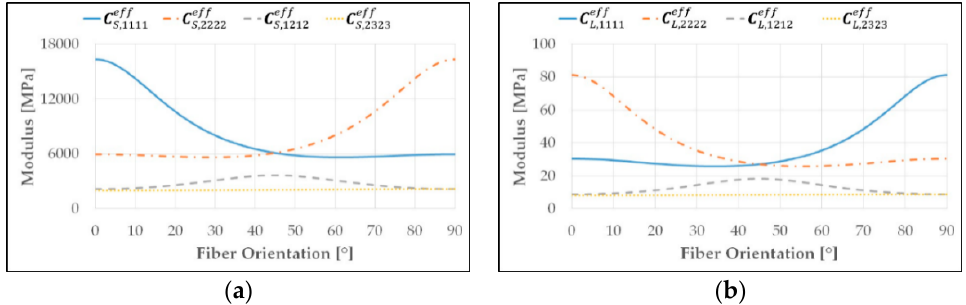
Figure 9. Components of the fourth ranked ( a ) stiffness and ( b ) damping tensors of PPA ‐ GF50 at 23 °C and 0% rh.